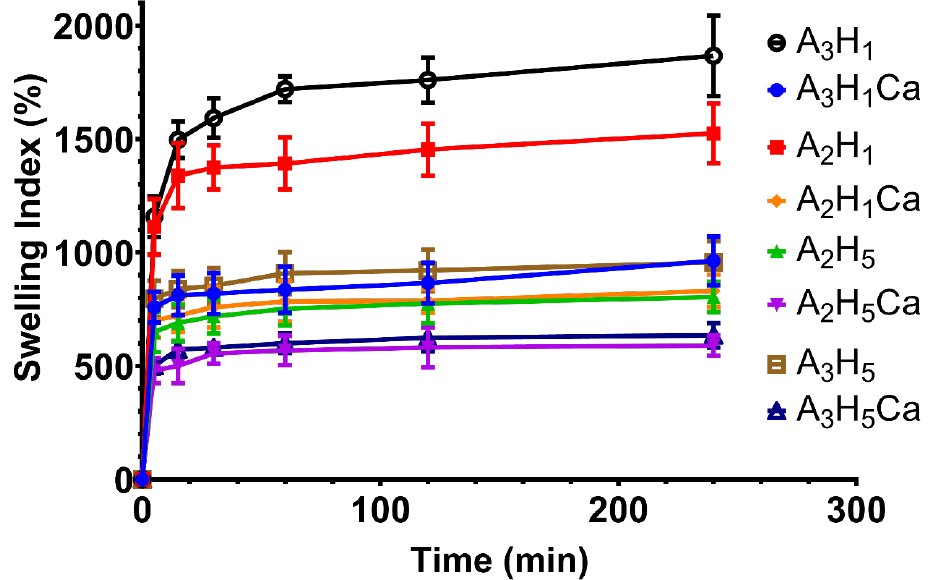
Figure 1. Swelling rates of alginate/nano-hydroxyapatite aerogels loaded with tranexamic acid in simulated body fluid (pH 7.4).